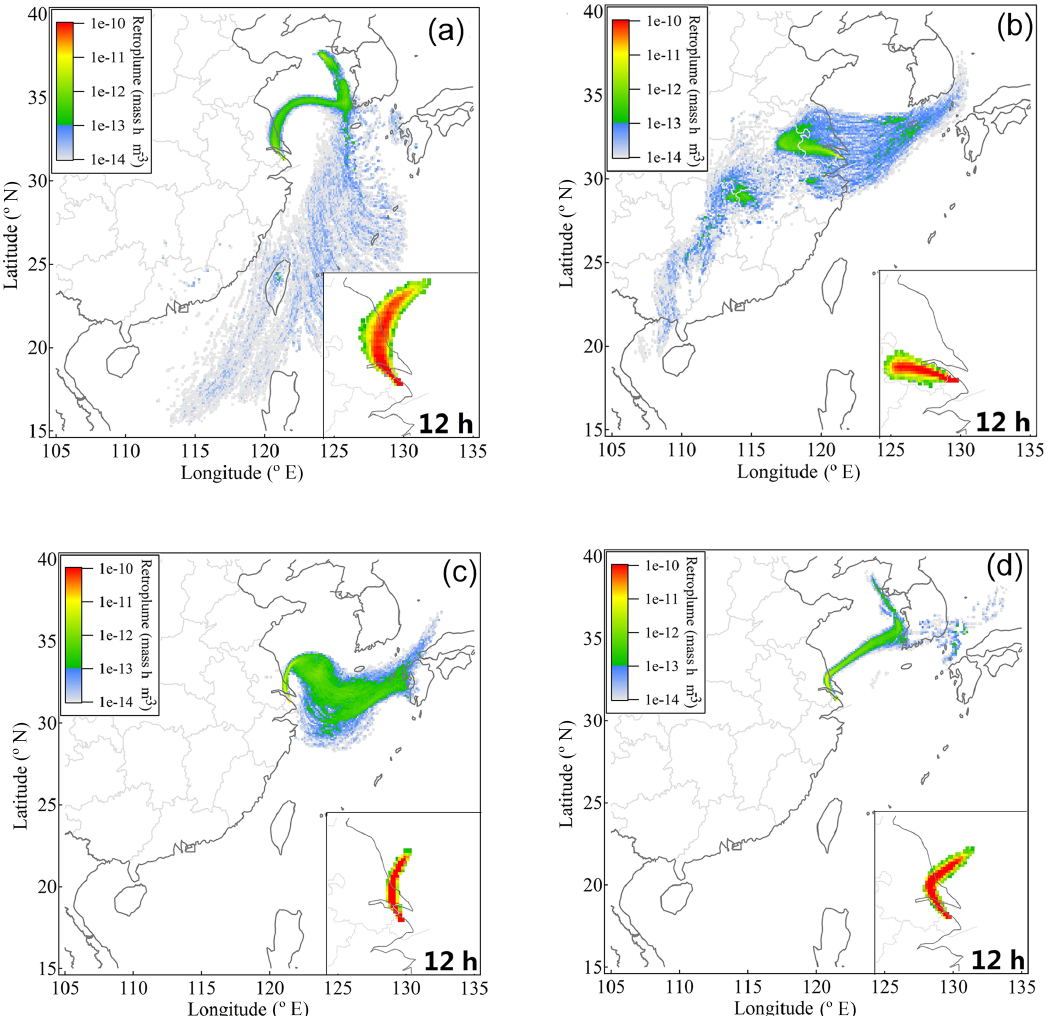
Figure 8. Three-day backward retro-plumes (100m above the ground level) from the sampling location at (a) 05:00, 12 August 2015; (b) 21:00, 20 August 2015; (c) 06:00, 21 August 2015; and (d) 06:00, 25 August 2015. The embedded boxes show 12h backward